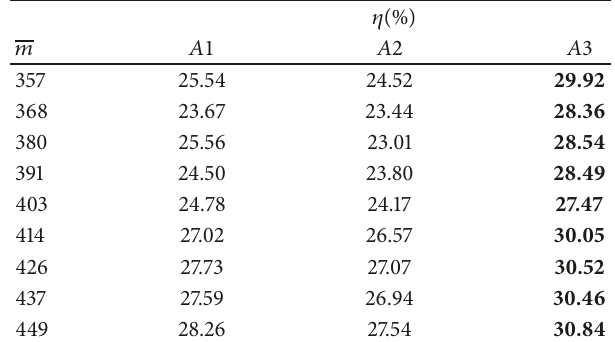
Table 7: Results of numerical experiments on Beijing Metro Yizhuang Line: A1 stands for the linear programming model (36) solved by Gurobi; A2 stands for the quadratic programming (37) solved by CVX; A3 stands for our proposed model (26) solved by Algorithm 1.